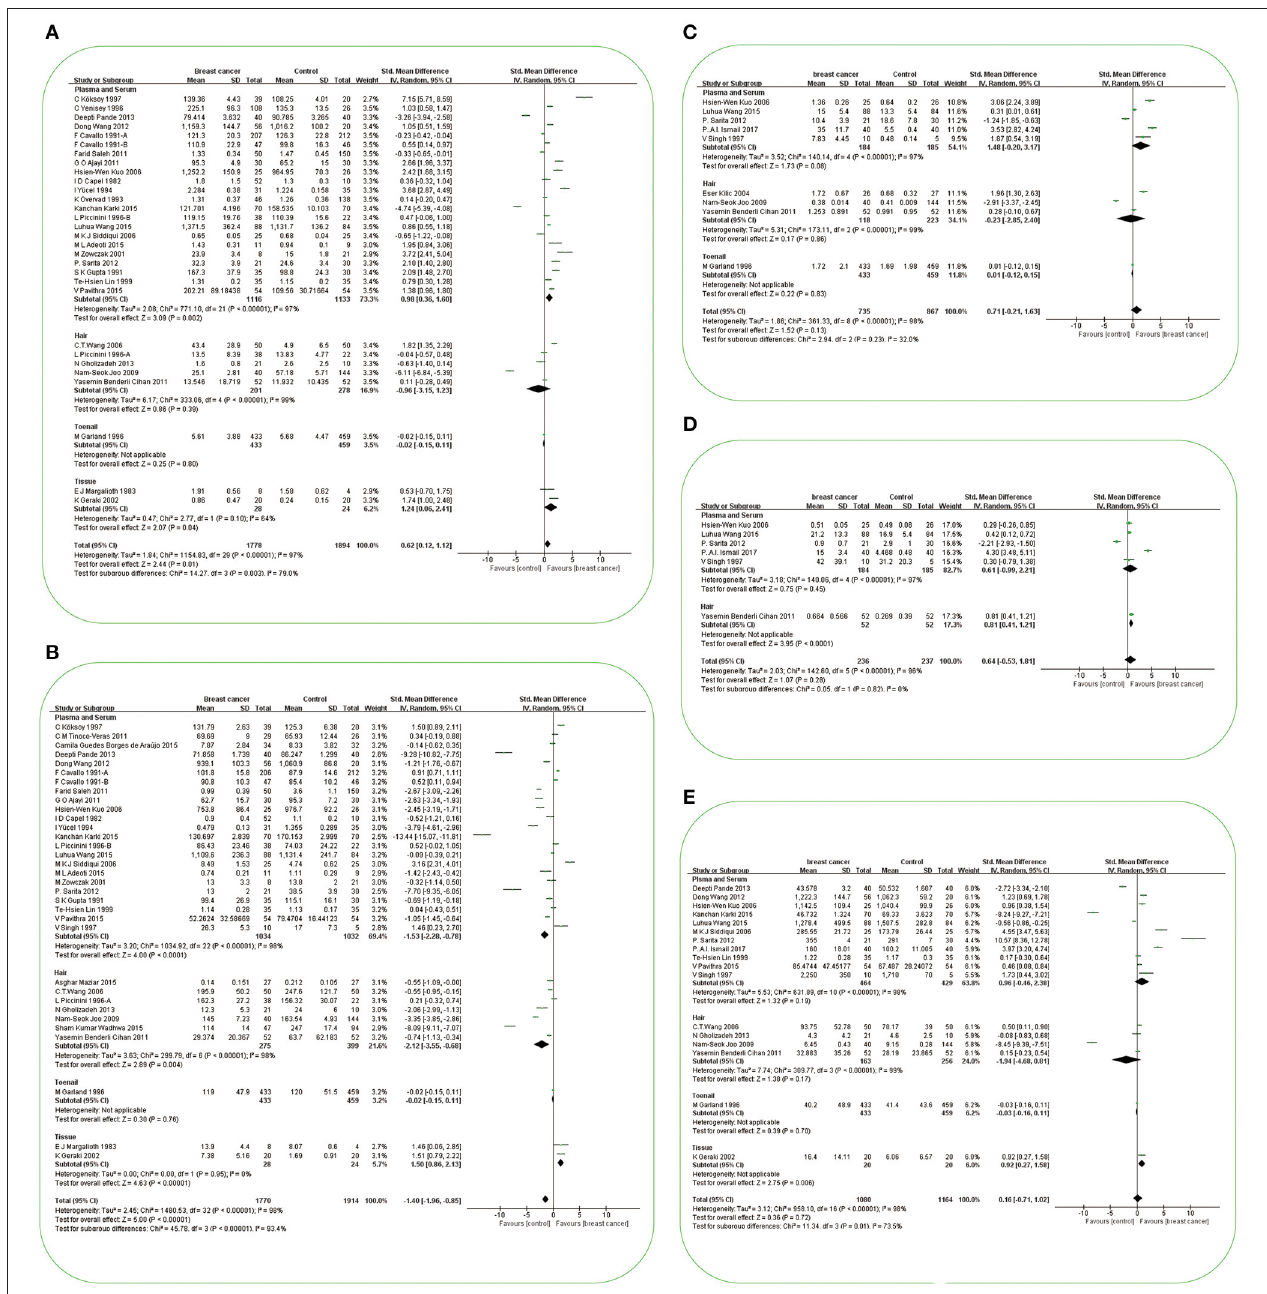
FIGURE 2 | Forest plot of studies of essential trace elements in subjects with breast cancer vs. non-breast cancer controls. (A) Forest plot of studies of Cu levels in subjects with breast cancer vs. non-breast cancer controls. (B) Forest plot of studies of Zn levels in subjects with breast cancer vs. non-breast cancer controls. (C) Forest plot of studies of Cr levels in subjects with breast cancer vs. non-breast cancer controls. (D) Forest plot of studies of Co levels in subjects with breast cancer vs. non-breast cancer controls. (E) Forest plot of studies of Fe levels in subjects with breast cancer vs. non-breast cancer controls. The standard mean differences (SMD) and 95% confidence intervals (CIs) were calculated using the random-effects model. Cu, copper; Zn, zinc; Cr, chromium; Co, cobalt; Fe,